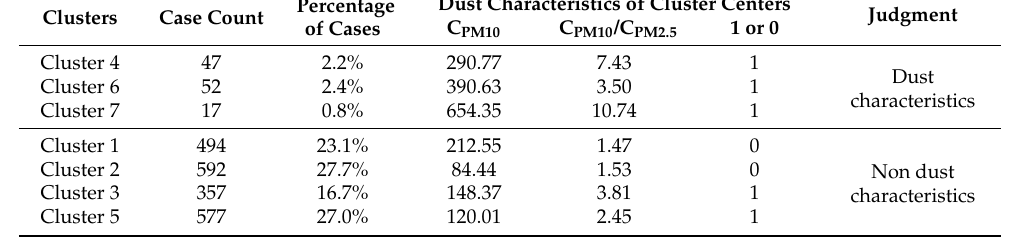
Table 3. The clustering results and dust data judgment of MDPD-k-means algorithm.